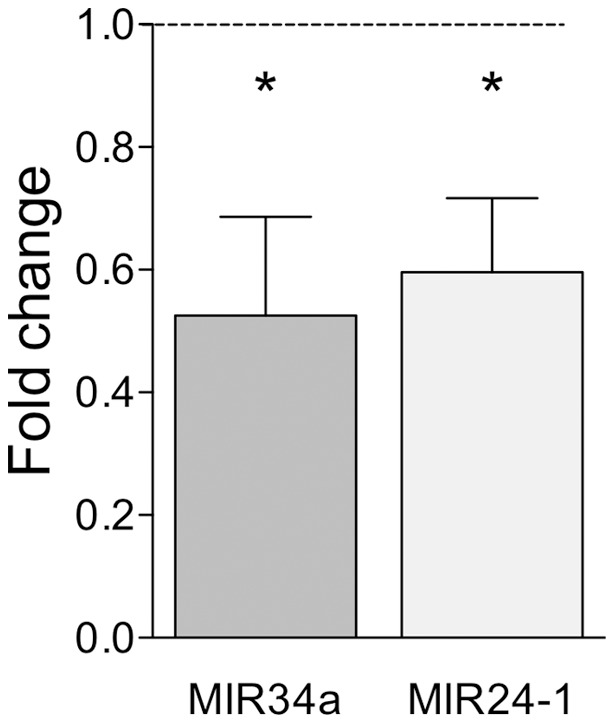
MicroRNAs identified by network analysis (5 h LRG-set) and validated by qPCR.Results are expressed as mean fold change +/− SEM. *p≤0.05, Student's t-test (n = 5–9). qPCR samples were normalised to the housekeeping gene Y1 using the 2−ΔΔCT method.